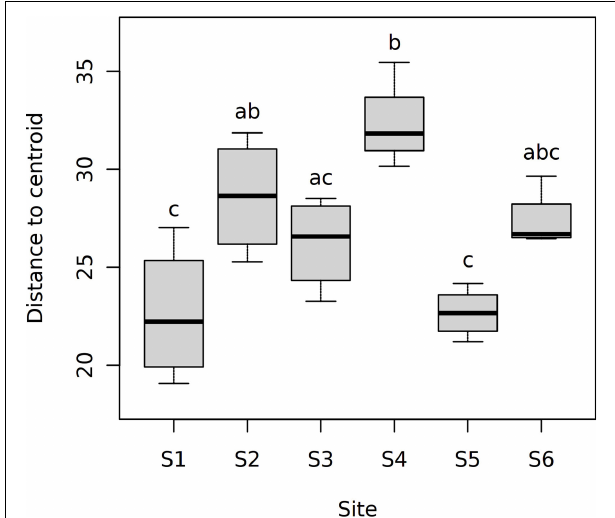
FIGURE 6 | Distances to the group centroid for CLR-transformed eukaryotic OTU abundance data. Data are shown for a total of six sampling sites in the Archipelago Sea (Baltic Sea, Finland). Different letters above the boxes indicate significant differences between sampling sites (Tukey’s HSD test, p <